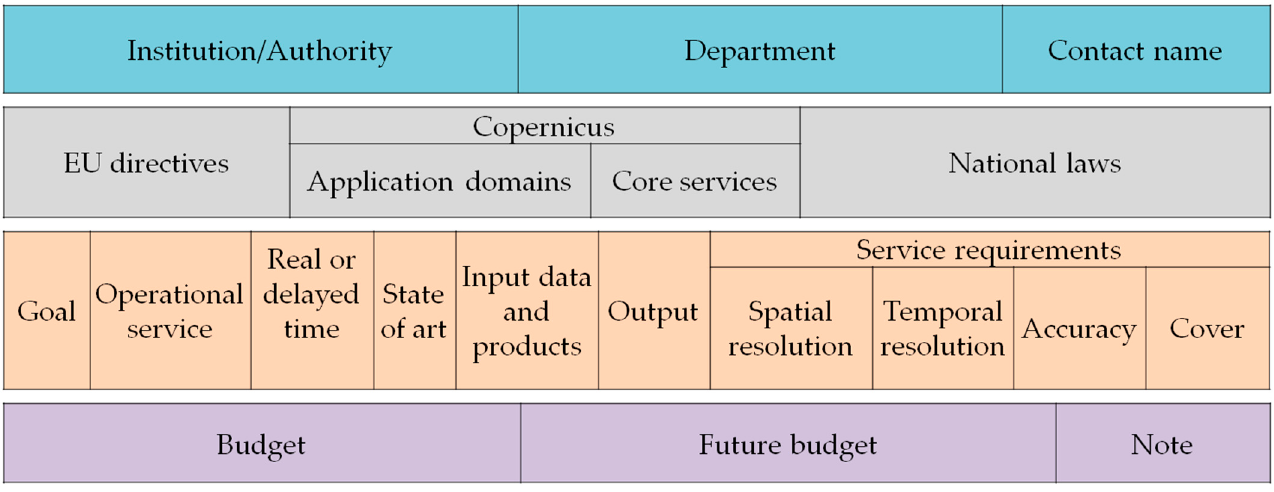
Figure 2. Questionnaire structure.